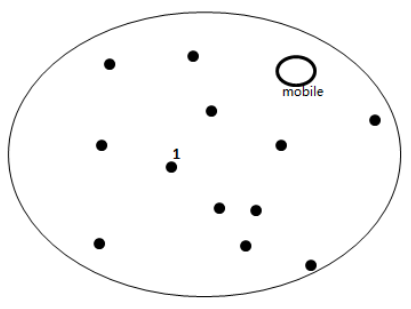
Fig.3. Deployment of nodes